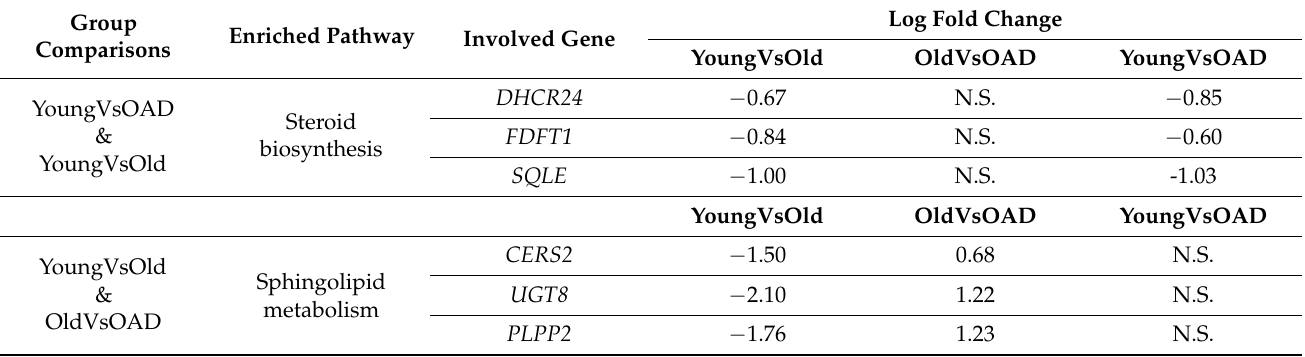
Table 1. Enriched pathways for DEGs commonly expressed among Young, Old, and OAD groups.